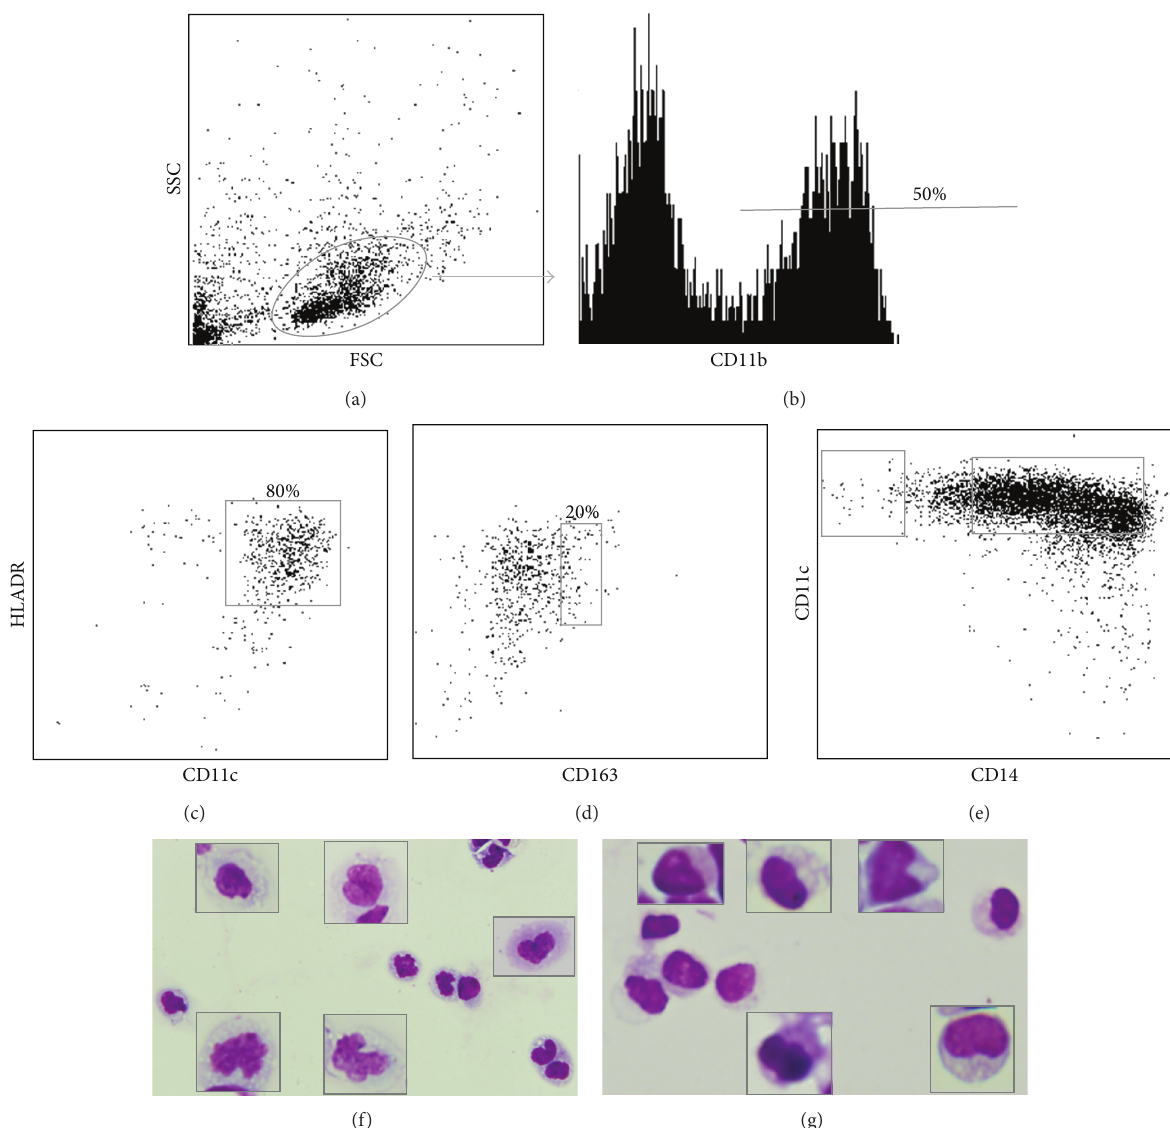
Figure 2: Flow cytometric analysis of cells prepared from SF aspirates. (a) Shows the selected gate based on forward and side scatter of light. (b) Shows CD11b staining of 50% of SF cells in a single peak. (c) Shows 3-colour flow cytometric analysis in which 80% of CD11b+ HLADR+ SF cells express CD11c. (d) Shows 3-colour analysis of SF cells in which 20% of CD11b+ HLADR+ cells express CD163. (e) Shows 4-colour analysis to separate CD14 − from CD14+ subsets of HLADR+ CD11b+ CD11c+ cells. The CD14 − cells were enriched for cells with DC morphology (f), whereas the CD14+ subpopulation displayed monocyte morphology